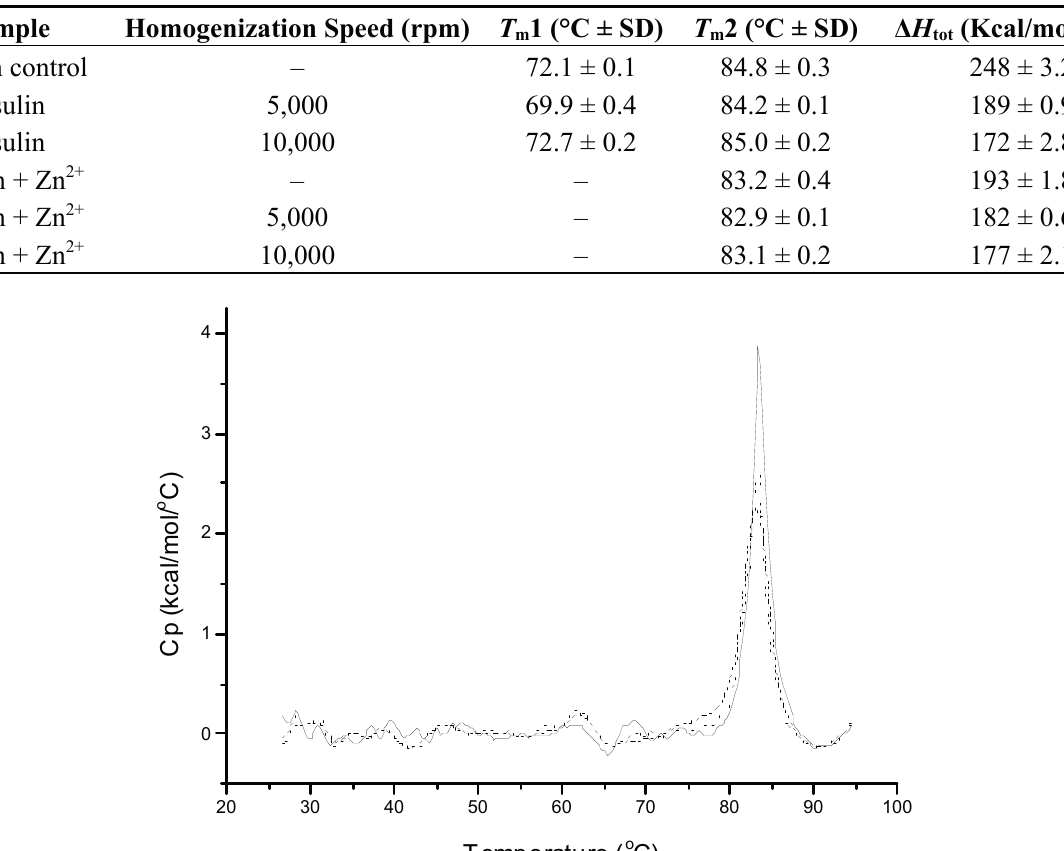
Table 2. Thermal parameters of recovered insulin after emulsification with methylene chloride in the presence of PLGA ( n = 3).